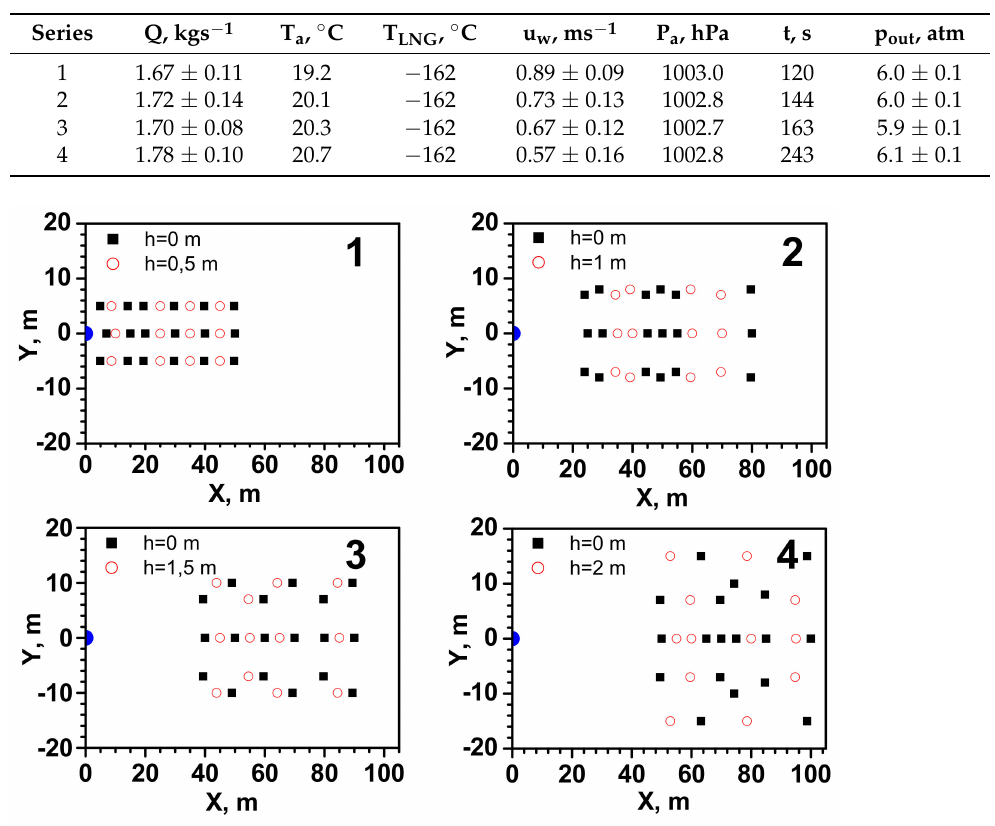
Table 1. Ambient and LNG release parameters during the 4 test runs. Designations: Q—LNG